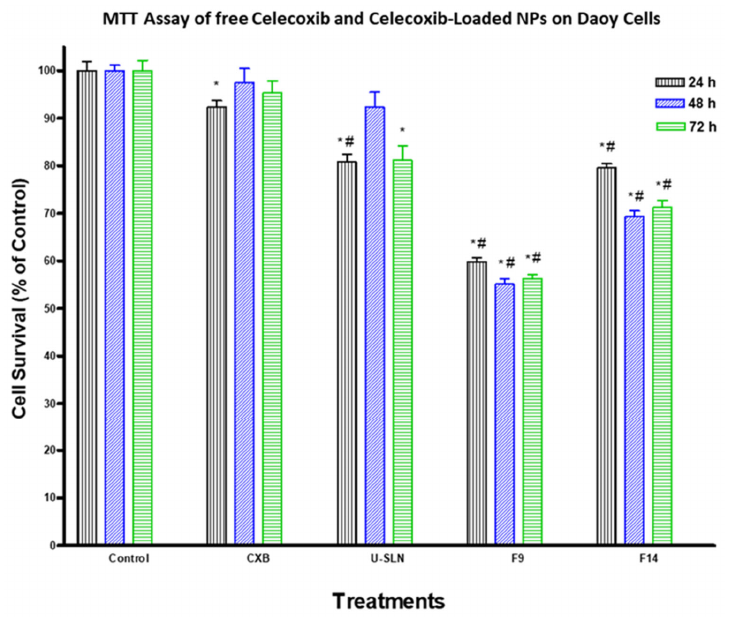
Figure 8. Effect of CXB and CXP–SLN on medulloblastoma cells. Daoy cells were treated with indicated formulas of CXB–SLN (F9, F14), unloaded SLN (U ‐ SLN), pure CXB or buffer (control) for 24, 48 or 72 h. Cell viability was determined by MTT assay, as indicated in Section 2. At the end of the assay, an absorbance of 549 nm was read on a microplate reader. Significant differences between treatments and control and CXB were analyzed by ANOVA followed by t ‐ test. * p < 0.05 compared with control (0 μ M). # p < 0.05 compared with CXB.